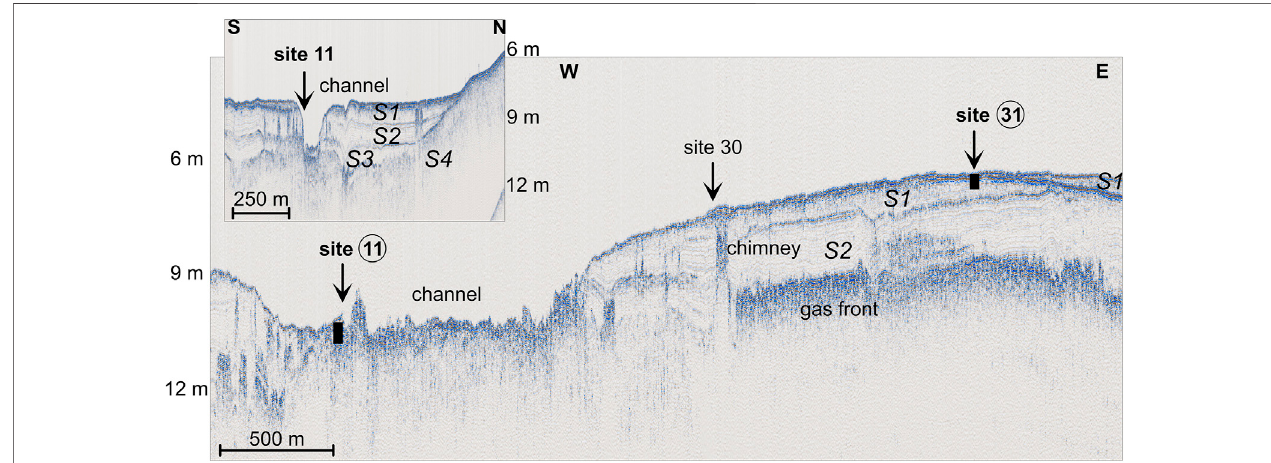
FIGURE 11 | Sediment acoustic pro fi le of the eastern W-E transect. The cores are marked as a circle around the site number, and the length of each core is denoted by the black bar. Inset: perpendicular S-N transect highlighting site 11.